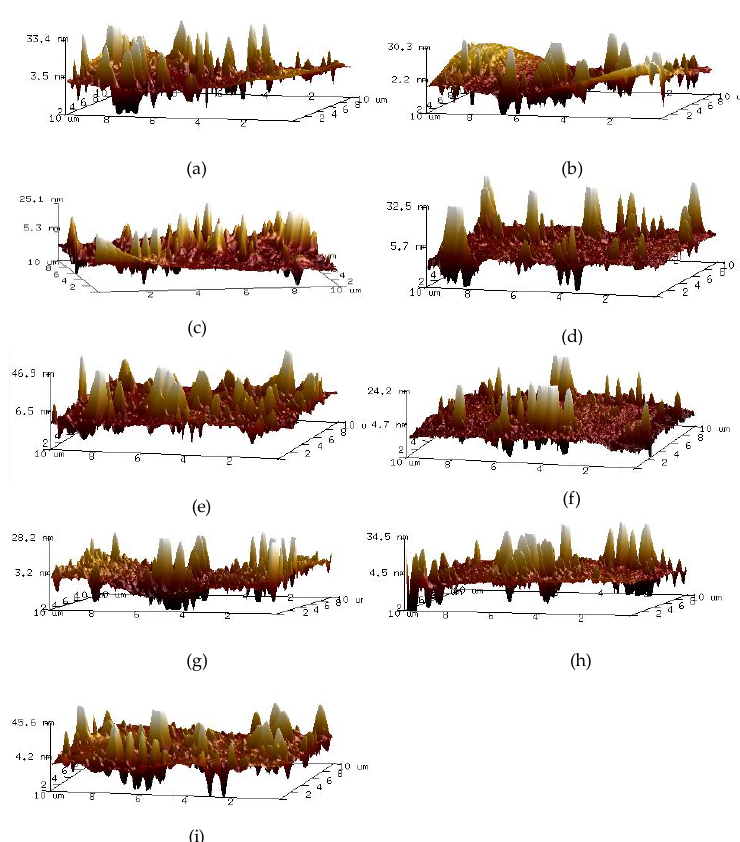
Figure 6. The three-dimensional nanoscopic images of bitumen with different ageing degree. The cooling rate of ( a – c ) is 12 °C/min; The cooling rate of ( d – f ) is 2 °C/min; The cooling rate of ( g – i ) is 1 °C/min; The ageing time of ( a , d , g ) is 0 min; The ageing time of ( b , e , h ) is 85 min; The ageing time of ( c , f , i ) is 240 min.